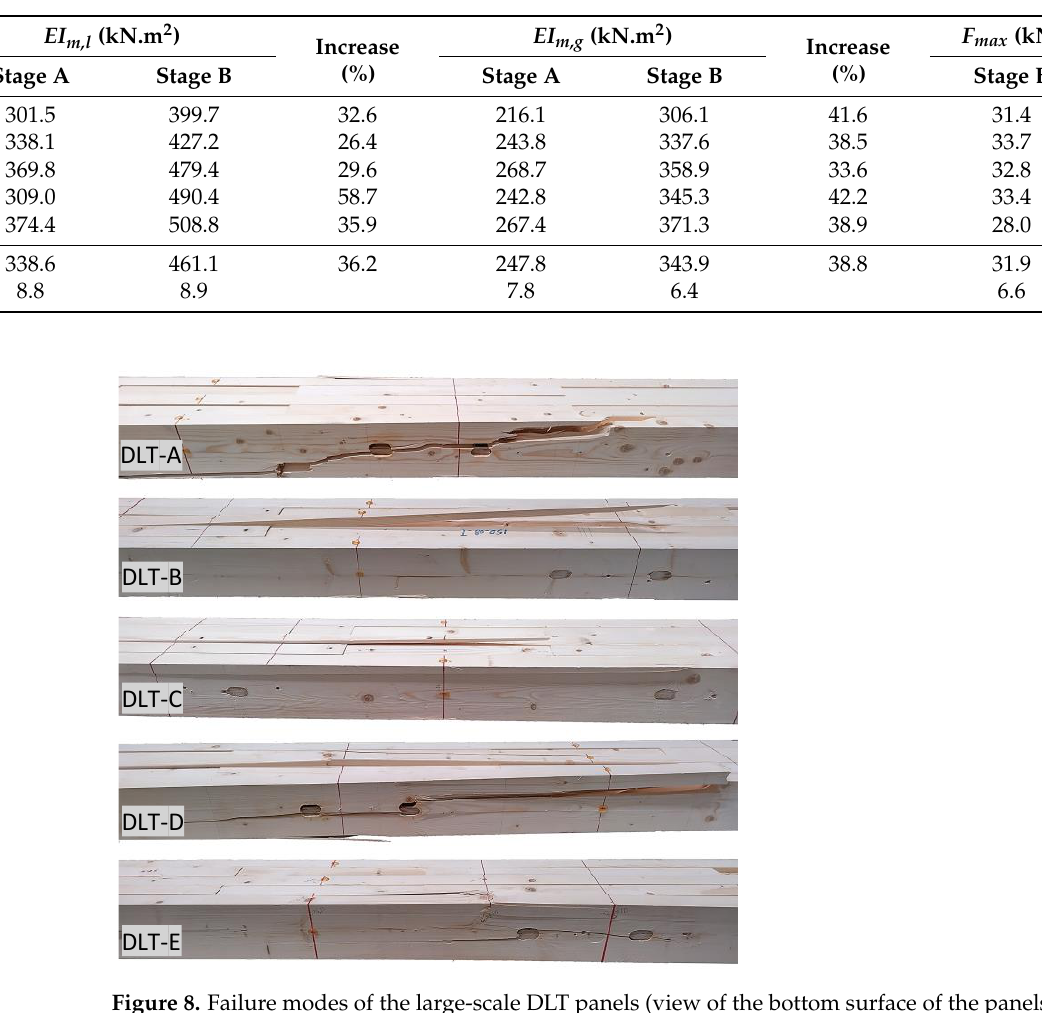
Figure 9. Shear deformations in the salvaged plywood tenons. 3.2.3. Bending Stiffness The bending stiffness (EI m,g and EI m,l ) for the two stages was calculated from different load ranges. For Stage A, the load carrying capacity was unknown, and in order to avoid any damage, a small load was applied; therefore, the load range used for the calculations was 1.35 – 5.42 kN. For Stage B, a larger load range (2.5 – 10 kN) was used. Nevertheless, considering the load – deflection curves of all the tested specimens (Figure 7), the following conclusions are not much affected by the selected load ranges. Overall, a considerable average increase of approximately 39% for EI m,g and 36.2% for EI m,l was observed after inserting the salvaged timber elements in the panels (Table 3). For both stages and stiffness parameters, the variation was relatively small (COV < 9%). The increase in the stiffness values may have resulted from the compression re- sistance provided by the salvaged timber elements. Furthermore, due to the length